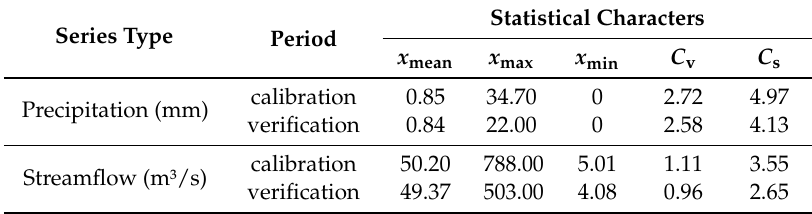
Figure 1. Location of the Heihe River Basin in China, and the hydrological station used in this study. Table 1. Statistical characters of the precipitation and streamflow data sets used for the study.